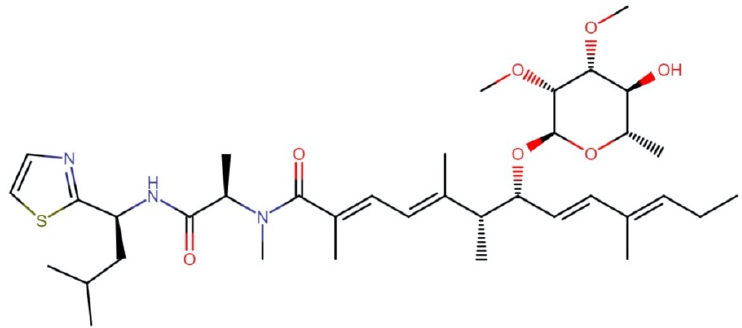
Figure 22. Chemical structure of iezoside.